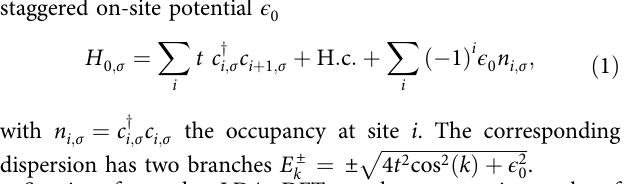
Starting from the LDA DFT results at a twist angle of ¼ 0 : 001337eV can be read off by the gap ϕ ¼ 6 : 61 (cid:1) , ϵ 0 magnitude at the zone edge, and an optimal fi t of the single remaining parameter t ¼ t k (see Methods section) is shown in = t (cid:4) 1 : 3, placing the system in the Fig. 2a. At this angle we fi nd ϵ 0 interesting regime where kinetic energy terms and staggering potential compete in their order of magnitude. More details about